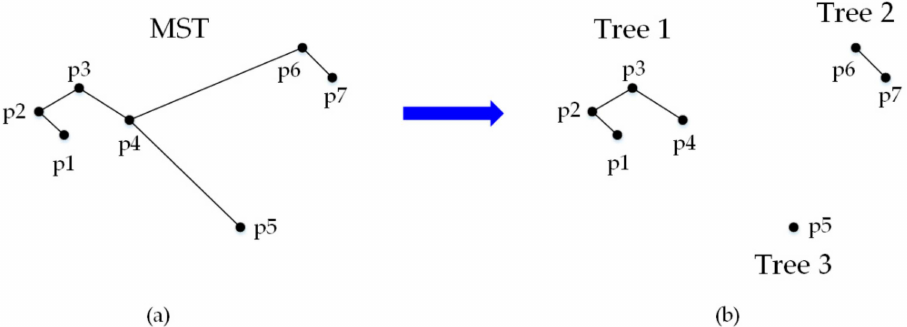
Figure 4. The minimum spanning tree (MST) ( a ) converting to a forest ( b ).